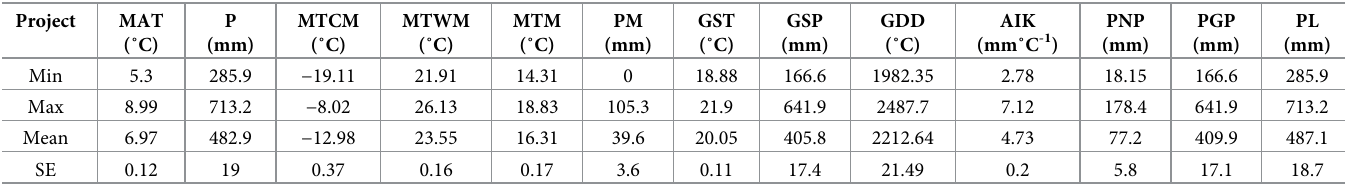
Table 2. Summary statistics of climate